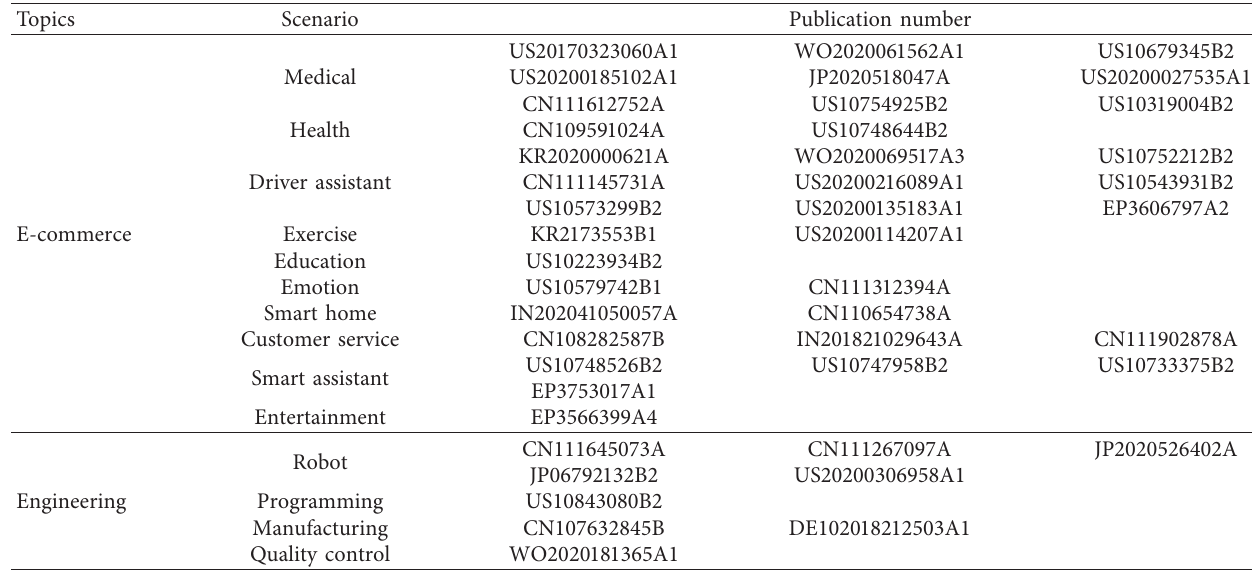
Table 7: The manual induction result by applied scenario.